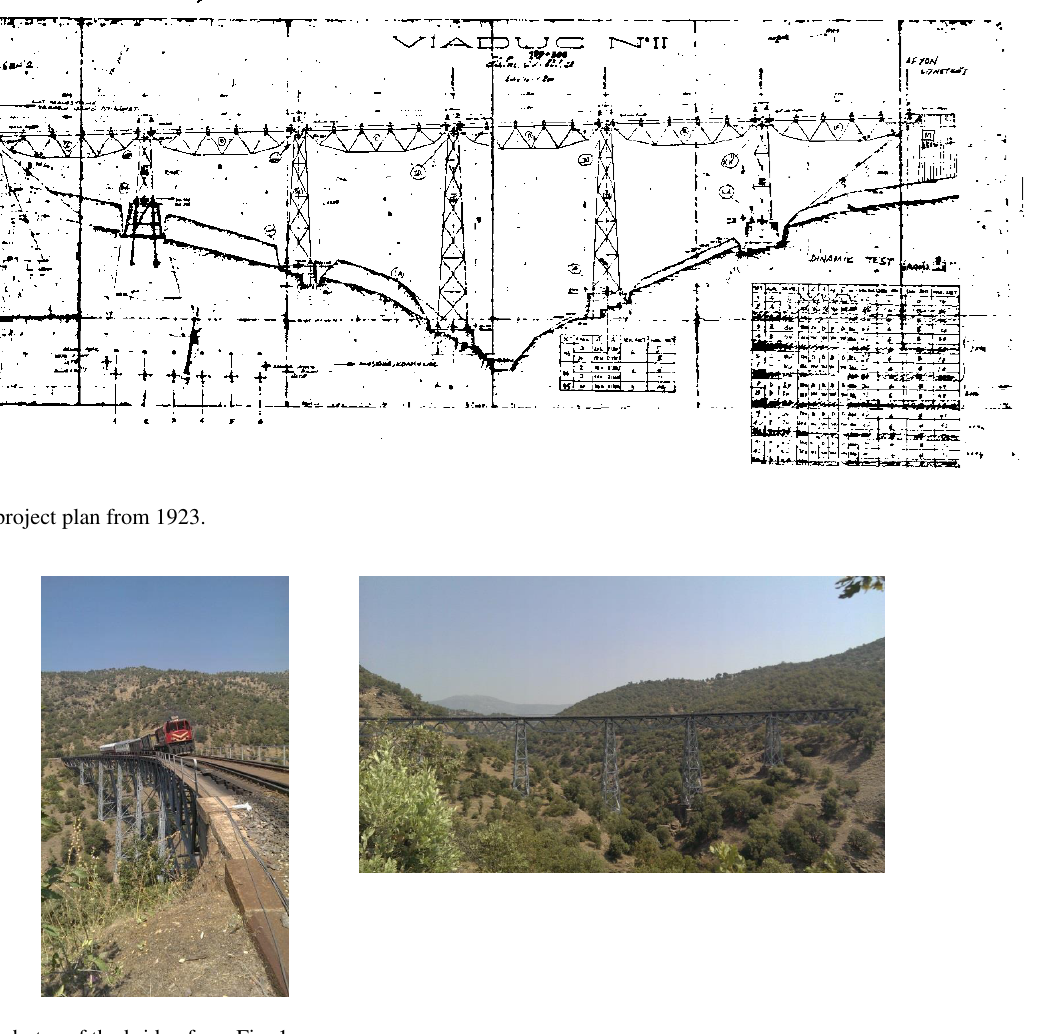
Figure 2. Current photos of the bridge from Fig.